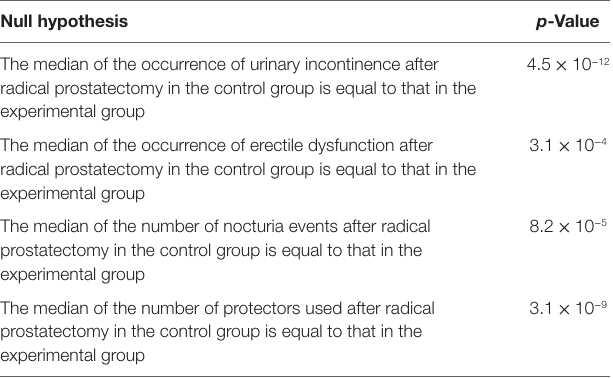
tABLe 6 | p -Value obtained for the hypothesis regarding increase in anal pressure for patients submitted to the proposed protocol. Null hypothesis p -Value The median of the anal pressures at the end of the sessions was equal to that at the beginning